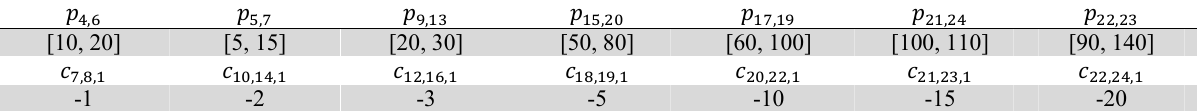
Information for interdependent projects